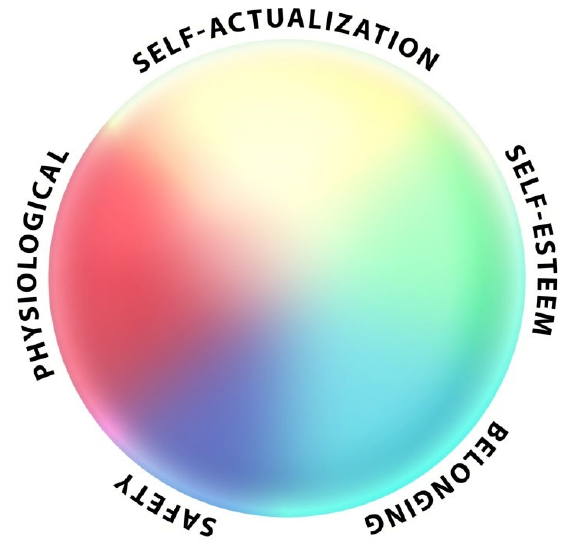
Figure 3. A sphere as a different way to represent multiple needs. A sphere demonstrates how a person can experience multiple needs at the same time. The boundaries between needs are fluid and adaptable.